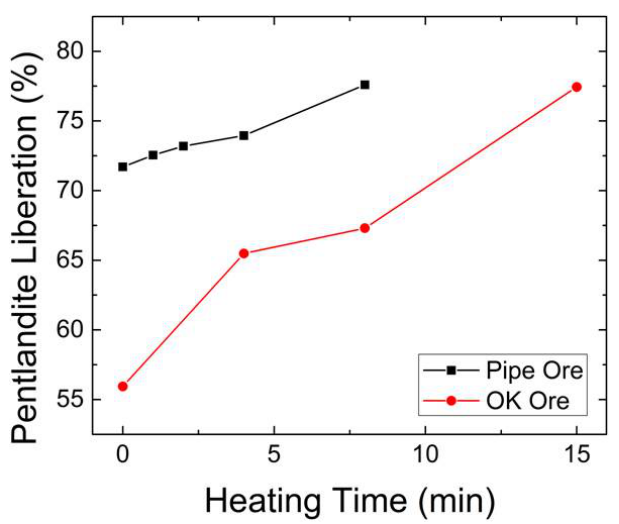
Figure 13. Pentlandite liberation versus microwave heating time after 15 min grinding for the Pipe and OK ores [48].